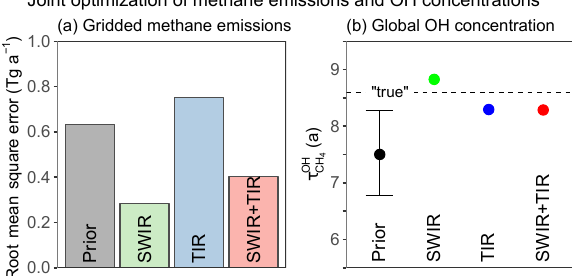
estimations with different satellite ob- CH 4